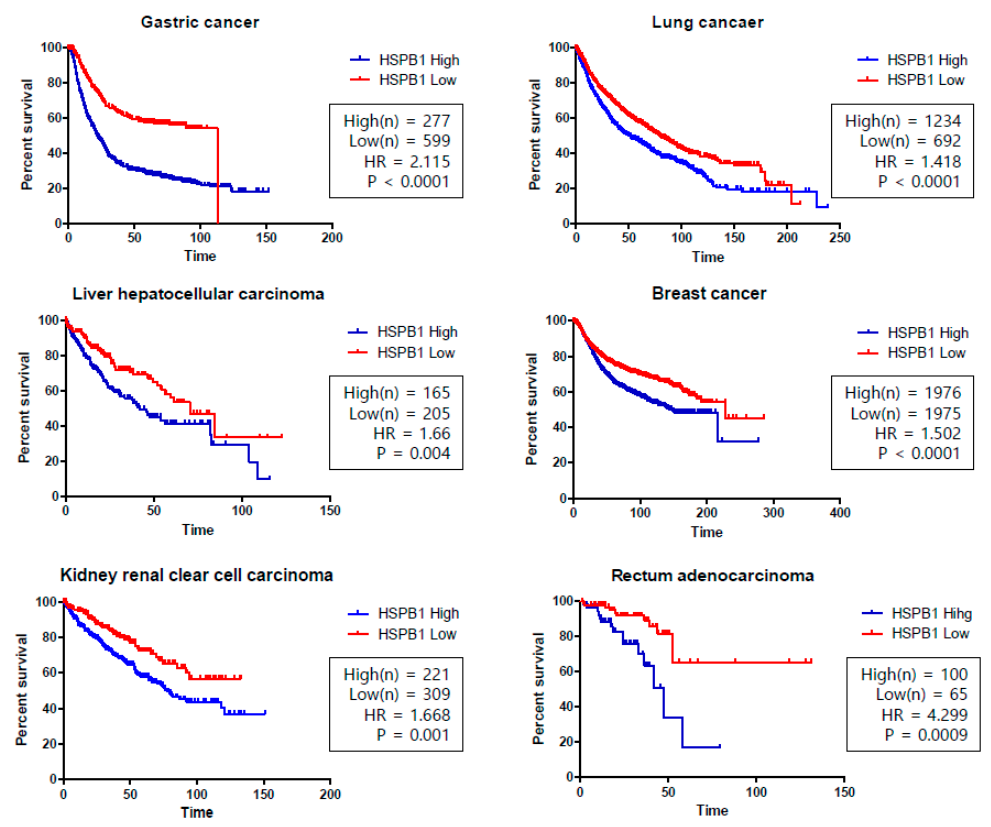
Figure 5. Kaplan–Meier (KM) curves for HSPB1 (gene name of heat shock protein 27 (HSP27)) in the overall survival of various cancers. Gastric cancer, lung cancer, hepatocellular carcinoma, breast cancer, clear cell renal carcinoma, and rectum adenocarcinoma show high survival rates associated with low HSPB1 expression. p -values were calculated using the log-rank test. The Hazard Ratio (HR) is the ratio of the hazard rates corresponding to the conditions described by two levels of an explanatory variable (HR > 1 was considered a higher hazard of death from the HSPB1 -High group). An independent univariate survival analysis of overall survival (OS) was analyzed based on a merged data set from the Kaplan–Meier Plotter [76] . Data were derived from http://kmplot.com/analysis/ and survival curves were drawn using PRISM software [77].